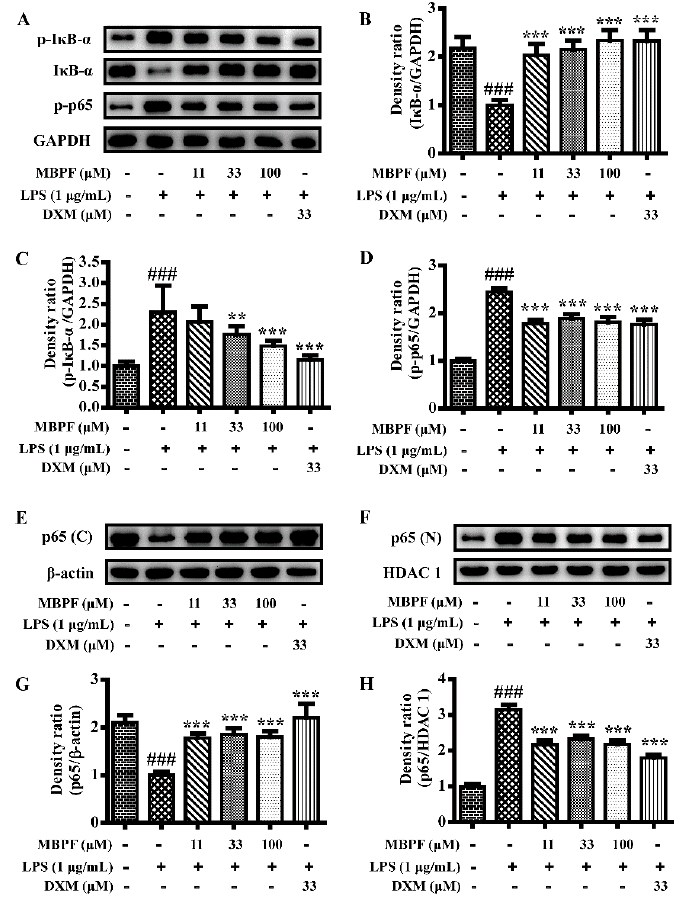
Figure 7. Effect of MBPF on LPS-induced activation of the nuclear factor κ B (NF- κ B) pathway in RAW264.7 cells. Cells were pretreated with various concentrations of MBPF (0, 11, 33, and 100 μ M) for 2 h and were then stimulated with or without LPS (1 μ g/mL) for 30 min. The protein levels of phospho-p65, phospho-I κ B- α , and I κ B- α were analyzed using Western blot ( A – D ). Cytosolic (C) and nuclear (N) protein were extracted to determine the levels of p65 using Western blot ( E – H ). The data represent the means ± S.E. of three independent experiments. ( ### p < 0.001 vs . control group; ** p < 0.01, *** p < 0.001 vs . LPS group).